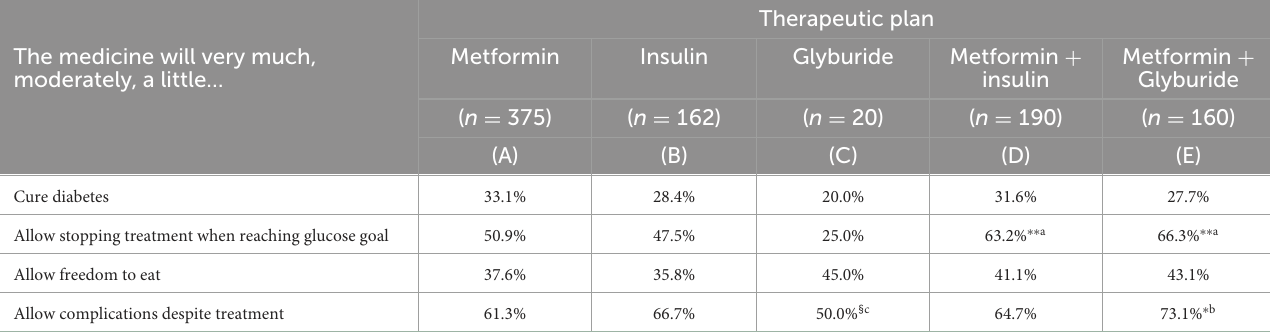
TABLE 4 Unrealistic expectations according to therapeutic plan.